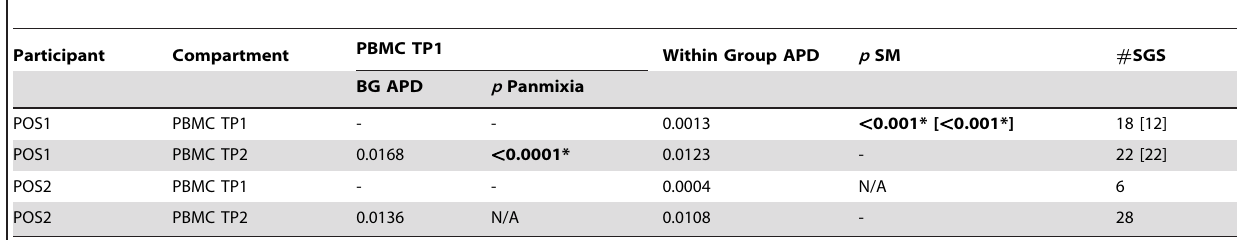
Nucleotide Distance Calculations with panmixia and Slatkin-Maddison (SM) probabilities for positive control (POS1 and POS2) patients. BG=Between Group, APD=Average Pairwise Distance and SM=Slatkin-Maddison Test. # SGS=number of sequences used per compartment in analysis after exclusion of hypermutated and recombinant sequences. For probability of panmixia, p -values , 0.05 are considered significant. For POS2 analysis for only one infectious variant is shown. # SGS in brackets for POS1 denote number of unique sequences used in Slatkin-Maddison Test. Bracketed Slatkin-Maddison probabilities denotes p SM following removal of duplicate sequences. *=Statistically significant; N/A=Not applicable.